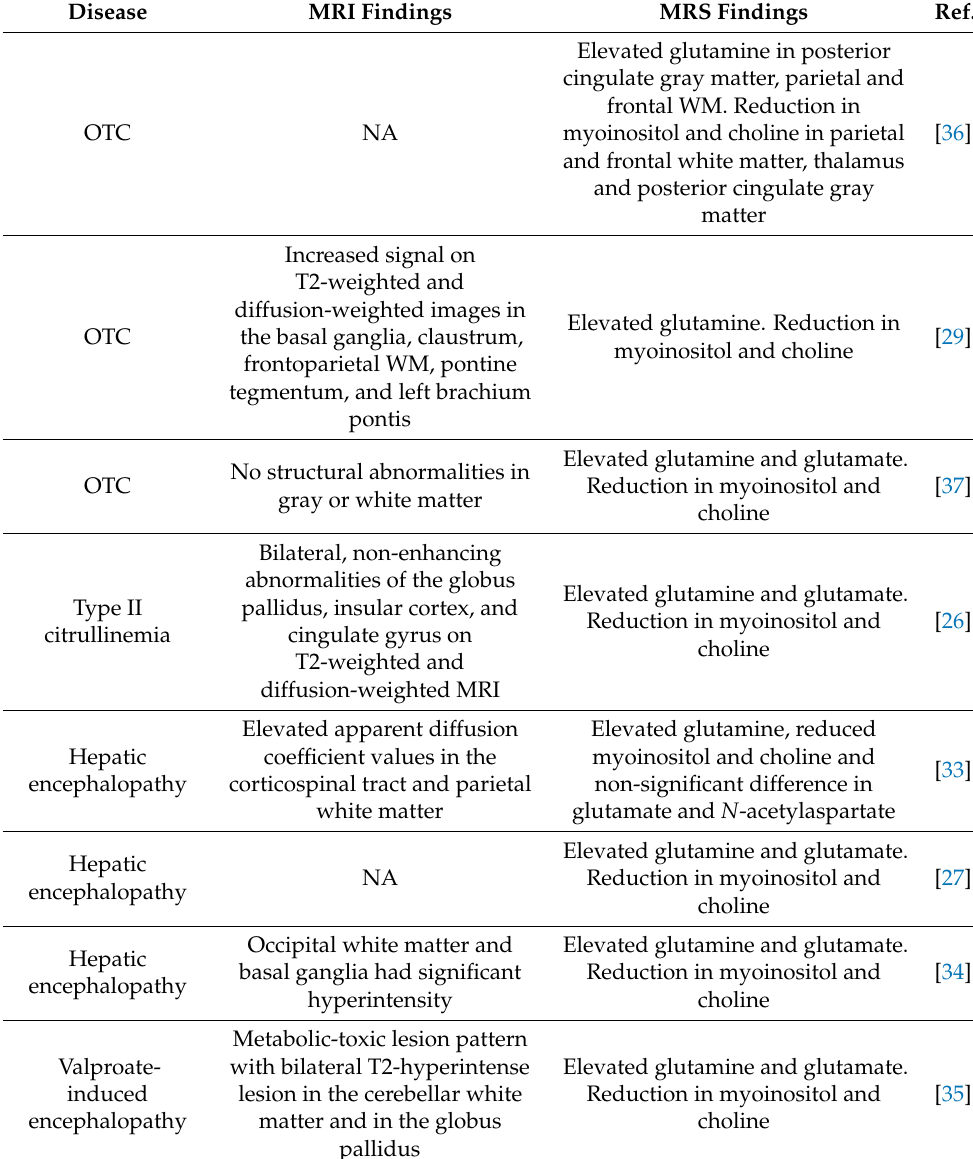
Table 1. Examples of brain MRI and MRS findings in adult patients with hyperammonemia due to urea cycle disorders, cirrhosis-related hepatic encephalopathy and drug-induced encephalopathy. Disease MRI Findings MRS Findings